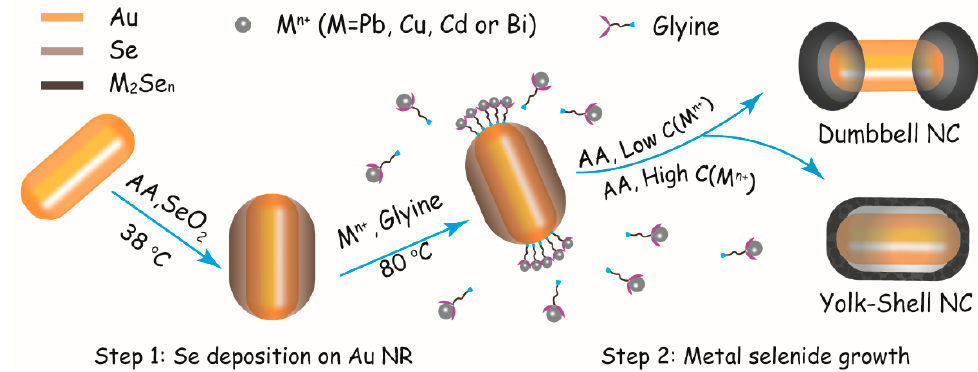
Figure 1. Schematic illustration of controlled growth of Au–selenide hybrid nanocrystals (NCs) with nanovoids. The symmetric distribution of nanoshells on Au nanorods (NRs) can be tuned from longitudinal (dumbbell-like) to transverse (yolk-shell) modes by simply adjusting the initial concentration of metal ion precursors.